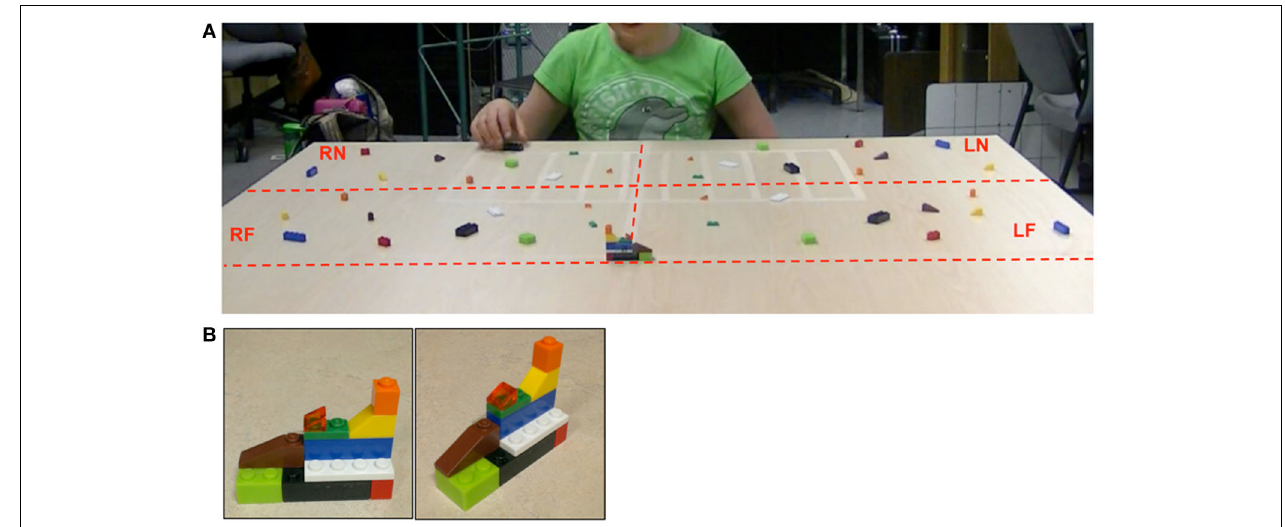
was notionally divided into four quadrants of equal dimensions (lines were not visible). Four identical sets of 10 pieces were placed on the tabletop—one set in each quadrant in near-mirror image placements. Within a set, pieces were unique in color and shape. The model to be